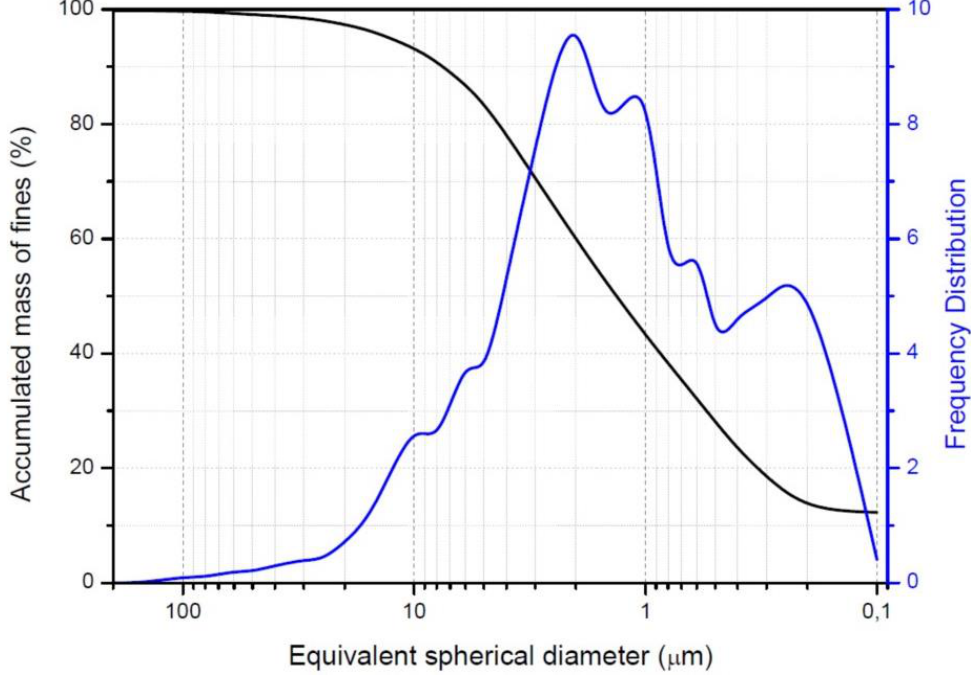
Figure 4. Distribution of morisca particle size.